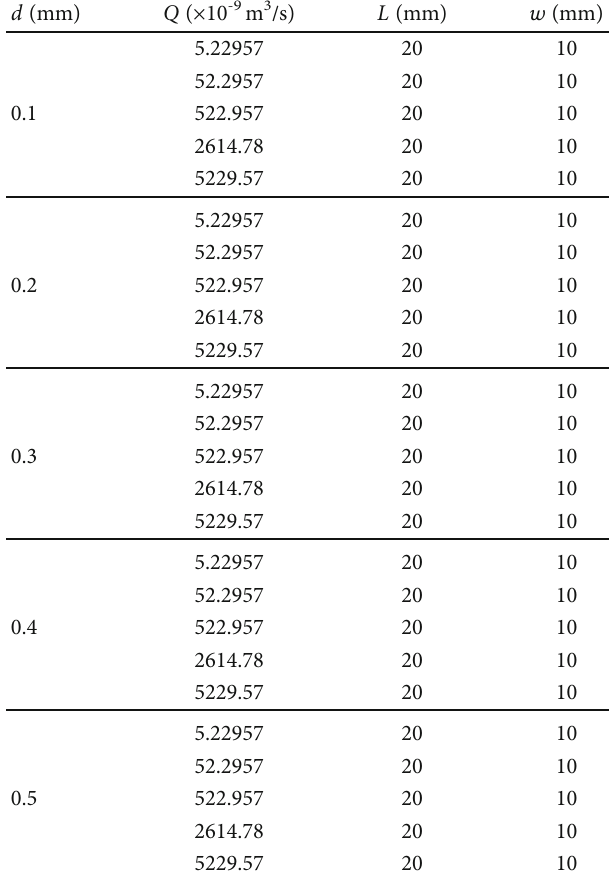
Table 1: Design of numerical simulations of fl uid fl ow through single rough-walled